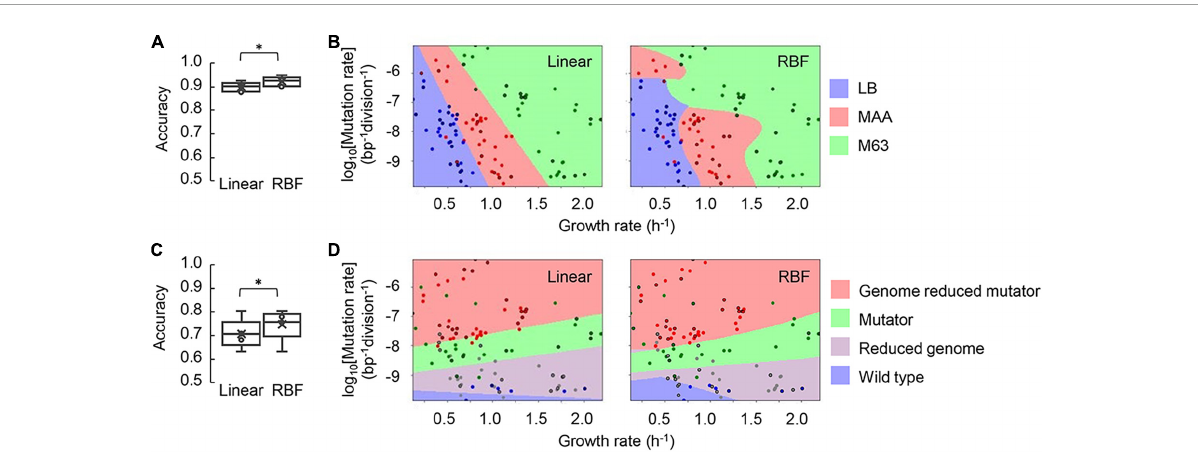
FIGURE6 Prediction of the medium and genotype by support vector machine. (A) Boxplots of the evaluation metrics of the machine learning models for medium classification. The accuracy of predicting the growth medium with either linear or RBF model of SVM is shown. Five independent tests with the data unused for training are indicated. Statistical significance is indicated (* p < 0.05). (B) Visualization of the medium clusters. One of five tests is shown as an example. Color variation represents the medium variety as indicated. The data points are signified by the dots, in which those for the test are circled by black lines and the rest for the training. (C) Box plots the evaluation metrics of the machine learning models for classifying the genotype. The accuracy of predicting the growth medium with either linear or RBF model of SVM is shown. Five independent tests with the data unused for training are indicated. (D) Visualization of the genotype clusters. One of five tests is shown as an example. Color variation represents the genotype variety as indicated. The data points are signified by the dots, in which those for the test are circled by black lines and the rest for the